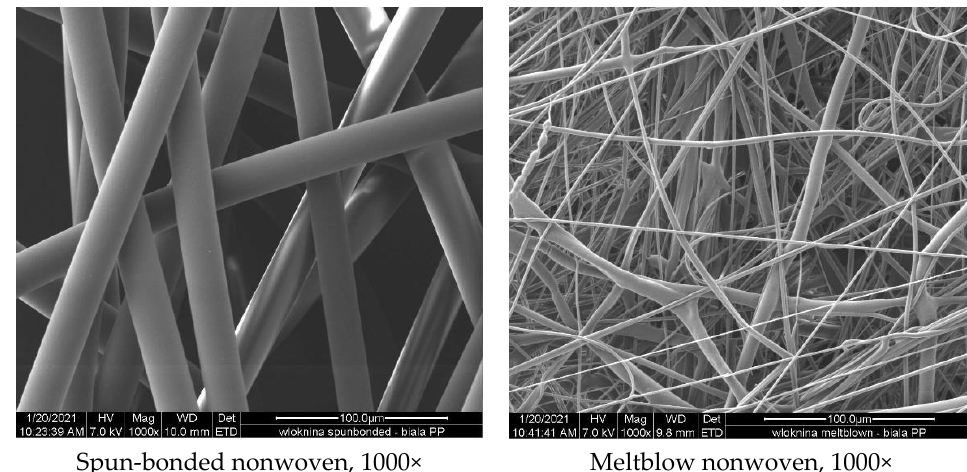
Figure 1. Difference in fiber diameter in spun-bond and meltblown technology.